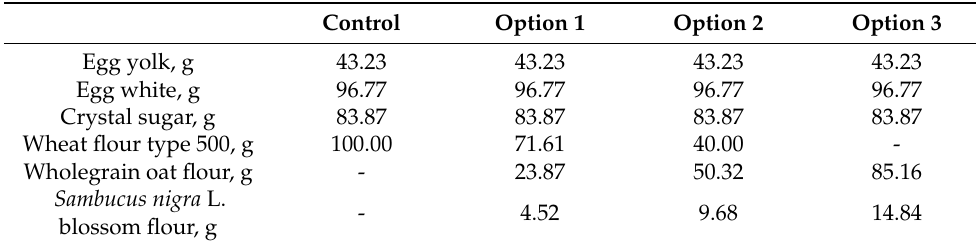
Table 6. Recipe composition of sponge cake dough, control, and partially substituted wheat flour with 5, 10, and 15% Sambucus nigra L. blossom flour and wholegrain oat flour.